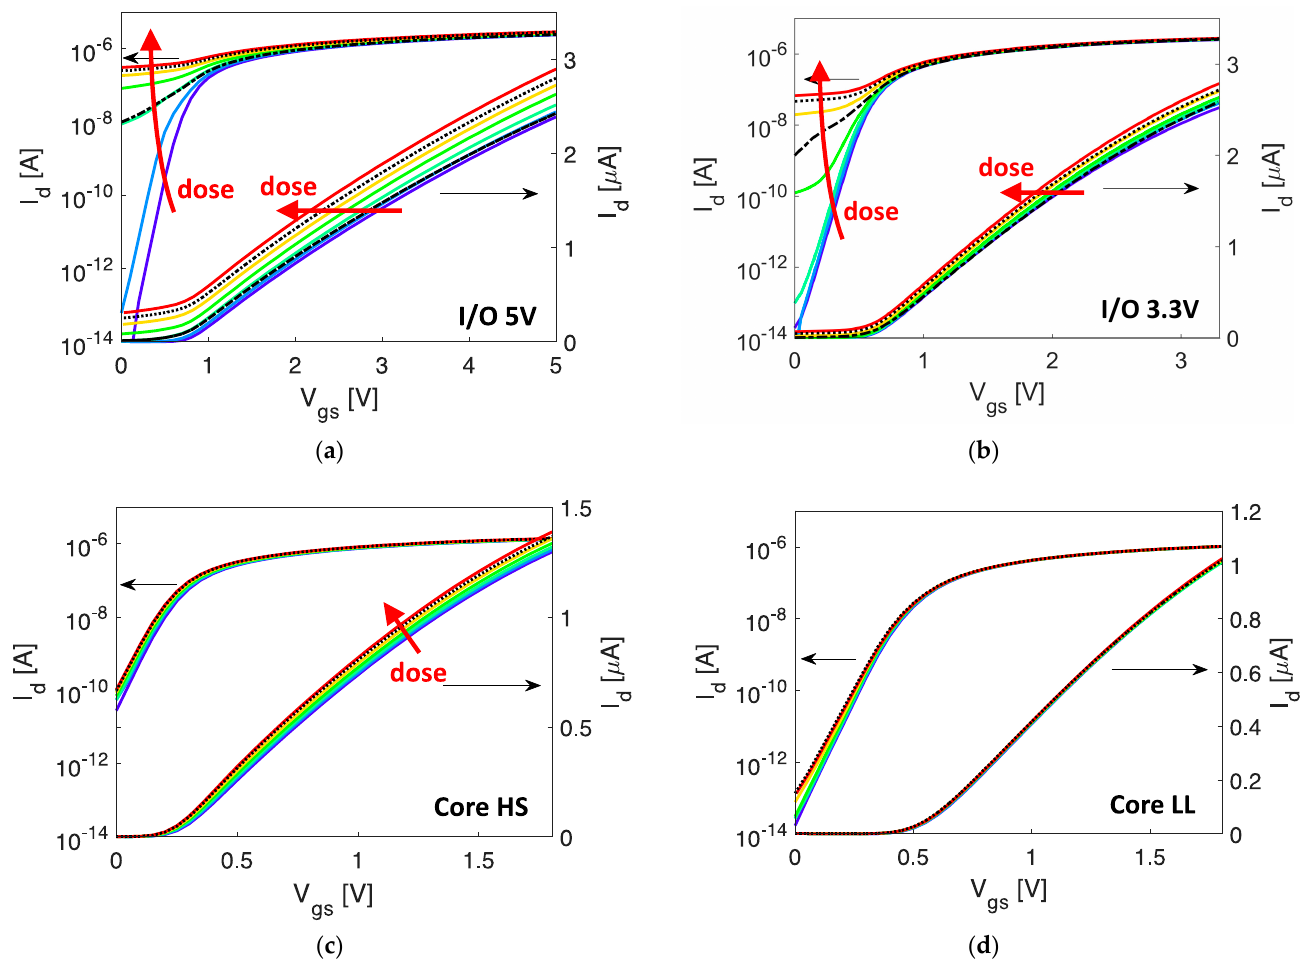
Figure 3. I d - V gs in the linear regime ( V ds = 0.1 V) at room temperature of nMOSFETs of different types with long and narrow channels (W/L = 0.8/10 μ m for I/O devices and W/L = 0.32/10 μ m for core devices). Transistors irradiated up to 125 krad(SiO 2 ), annealed at room temperature for 24 h, and finally annealed at 100 °C for 24 h (only I/O devices). ( a ) I/O 5V, ( b ) I/O 3.3V, ( c ) core HS and ( d ) core LL.